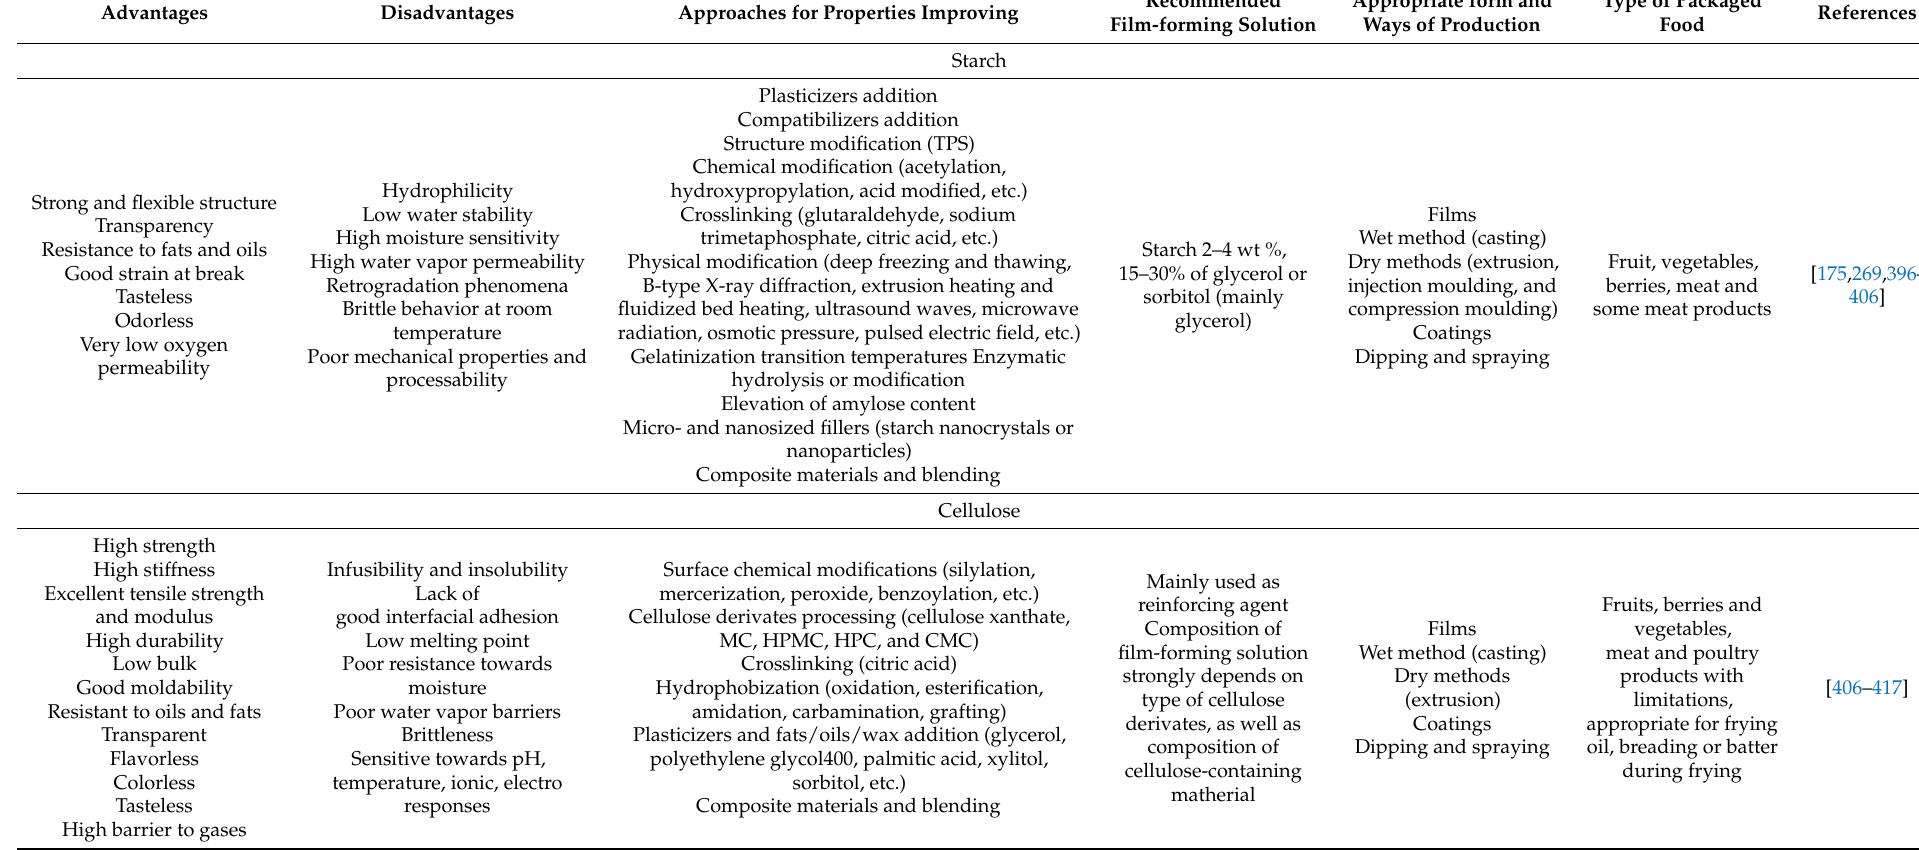
Table 1. The main characteristics of packaging materials based on animal proteins and natural polysaccharides and ways of its improving, production and